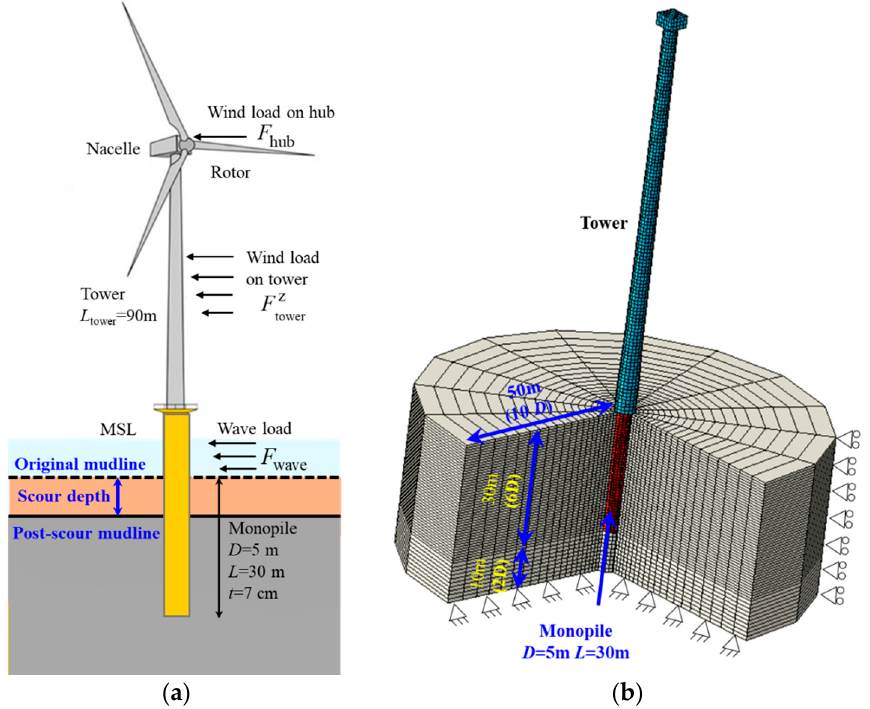
Figure 2. Diagram of: ( a ) the offshore wind turbine supported on a monopile foundation modelled in this study; ( b ) three-dimensional finite element mesh and boundary conditions.